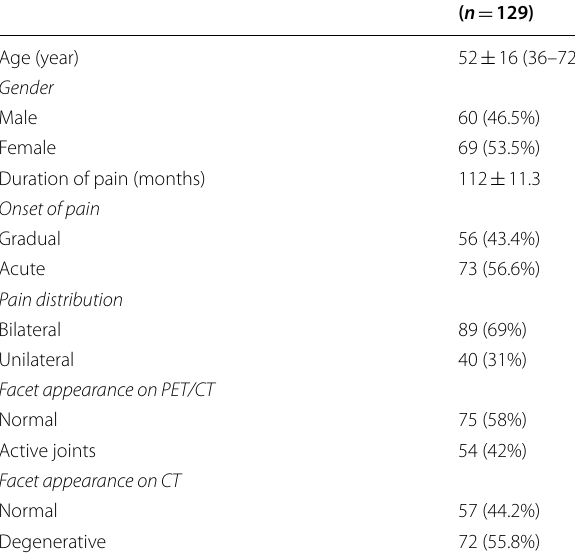
Table 1 Demographic data of 129 patients with back pain and no neurologic or radiologic findings of intervertebral disk